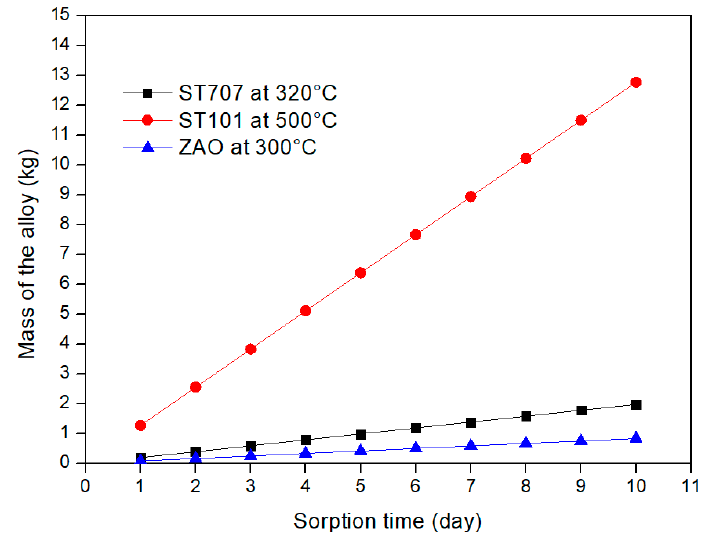
Figure 7. Mass of the different alloys required for DEMO CPS application vs. sorption time.